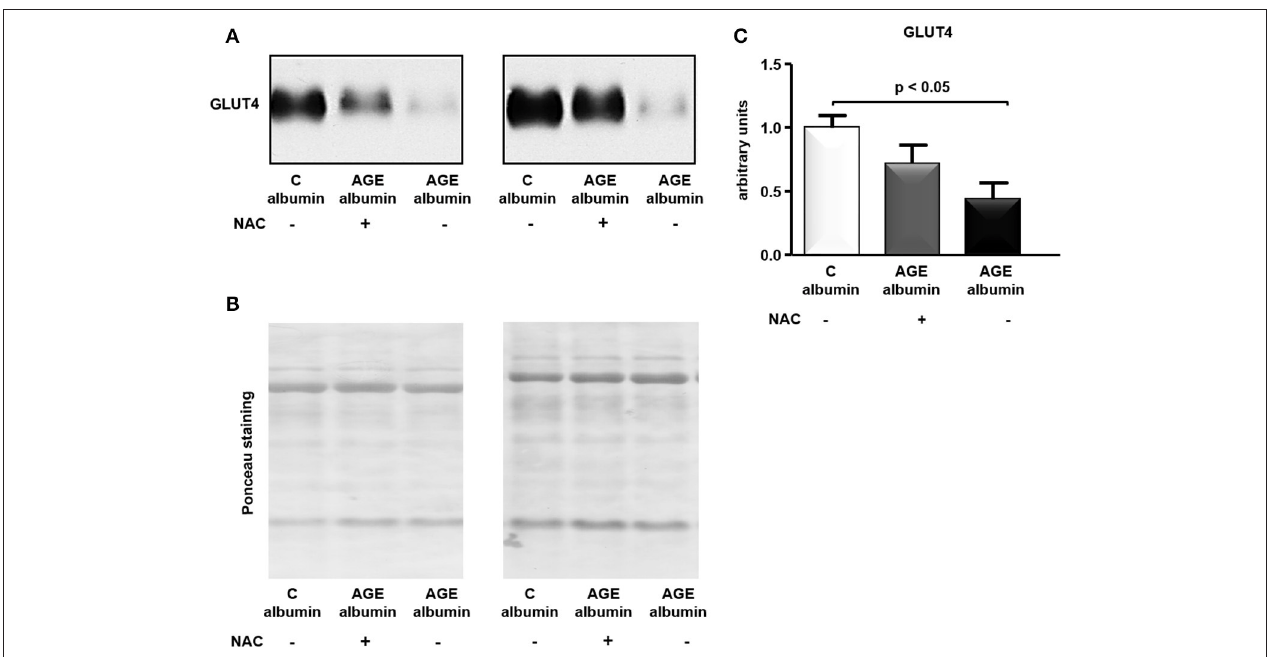
FIGURE 6 | GLUT4 protein level in periepididymal adipose tissue. GLUT4 was determined in adipose tissue from animals treated with C-albumin ( n = 4), AGE-albumin ( n = 6), and AGE-albumin + NAC ( n = 6); equal amounts of cellular protein were applied into a 10% T SDS-polyacrylamide gel and then submitted to immunoblot using rabbit polyclonal antibody against GLUT4 (1:3000; EMD Millipore, Bilerica, MA, USA, #07-1404). The blots were quantified by densitometry (ImageQuant TL, Amersham Biosciences UK Limited) (representative images, A ). The Ponceau-stained nitrocellulose membrane was used as loading control (B) ; after Ponceau normalization results were expressed as arbitrary units considering the mean of the control as 1 in each gel (C)